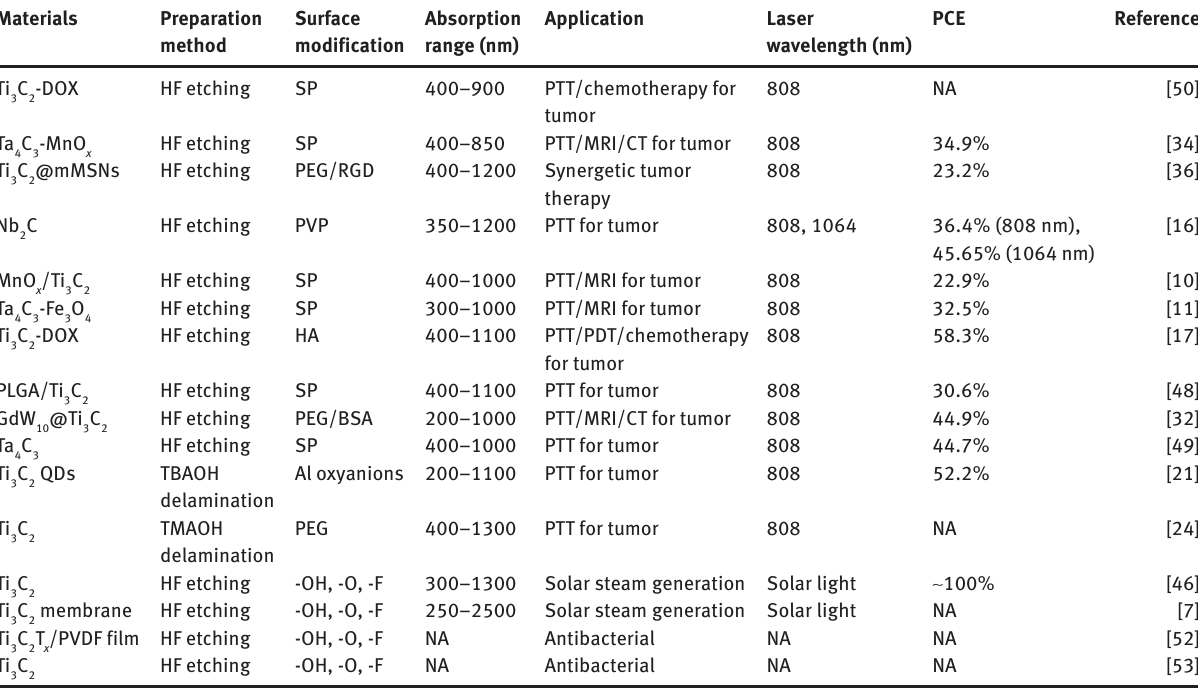
Table 1: Application of MXenes in PTT.